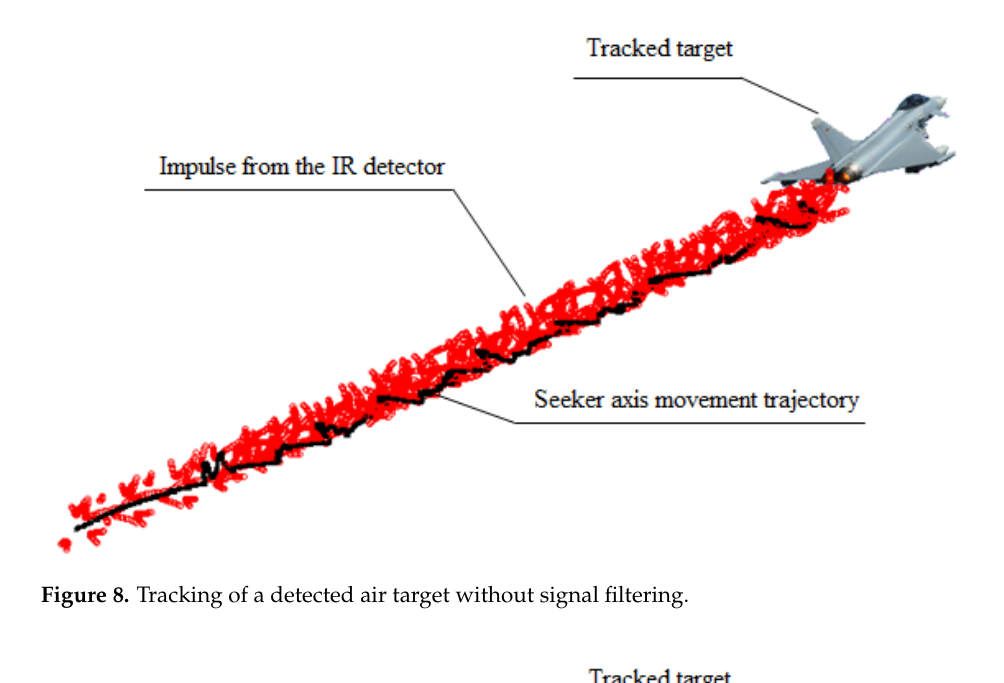
Figure 8. Tracking of a detected air target without signal filtering.